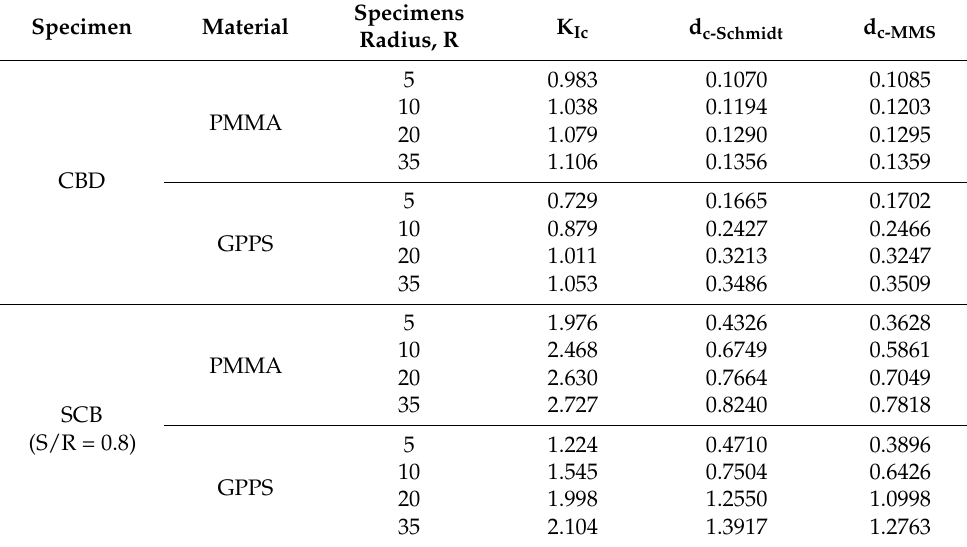
Table 6. The values of d c for PMMA and GPPS obtained from CBD and SCB samples. K Ic in MPa.m 0.5 , d c values in